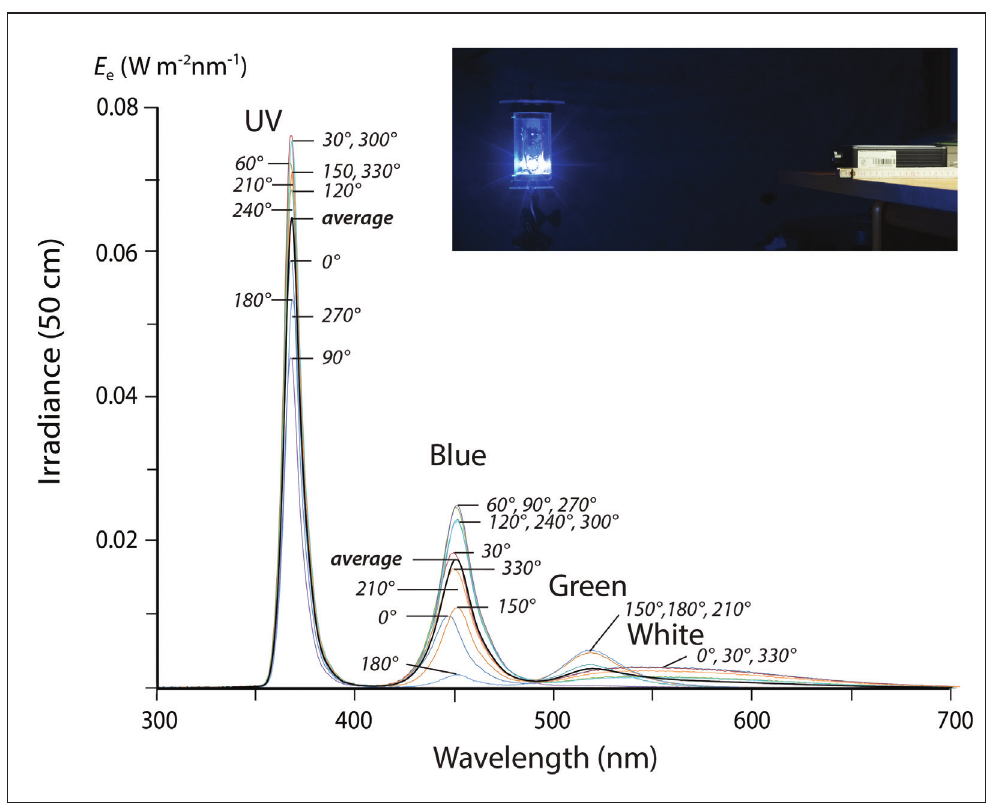
Figure 3. The irradiance of the new lamp was measured at a distance of 50 cm around its circumference at 12 points giving 30° between each. Average value: black